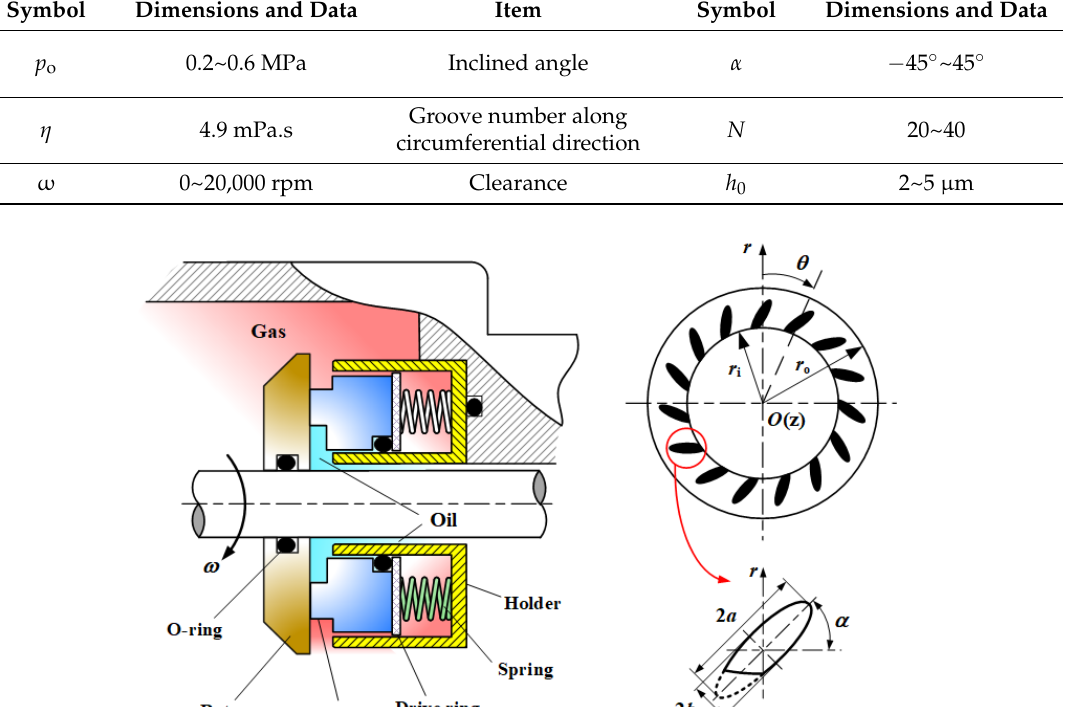
Figure 1. Schematic of the mechanical face seal with inclined elliptical grooves. ( a ) structure of mechanical seal; ( b ) periodic distribution of elliptical grooves